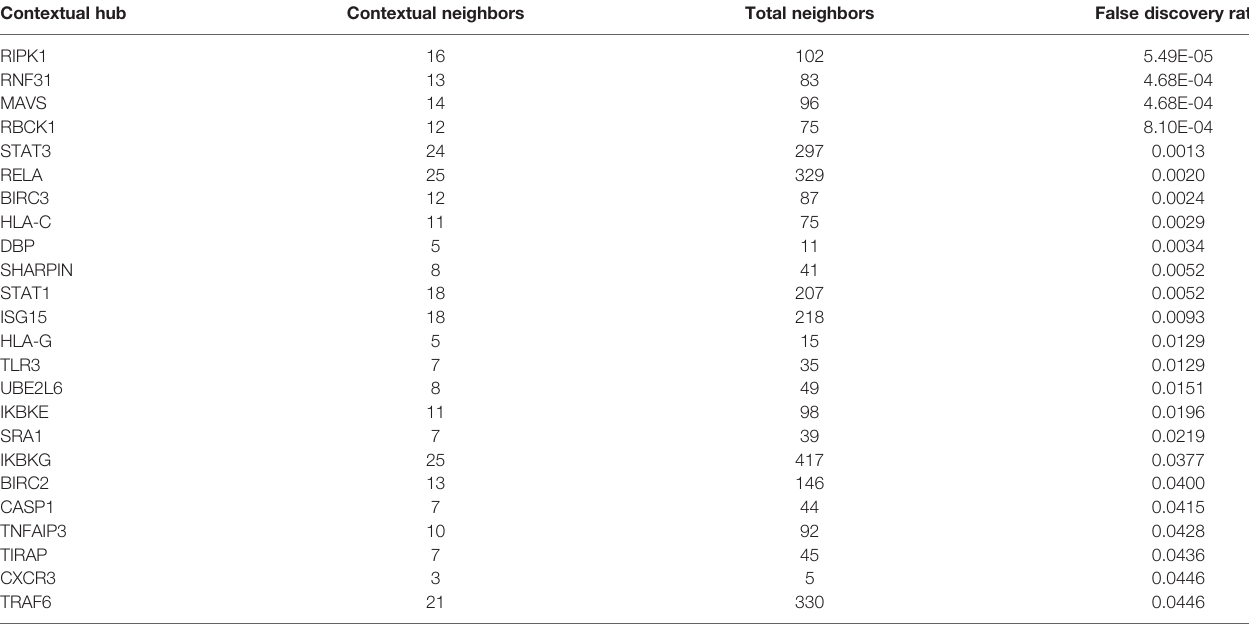
BIRC3, baculoviral IAP repeat-containing protein; CASP1, caspase 1, apoptosis-related cysteine protease; CXCR3, chemokine, CXC motif, receptor 3; DBP , d-box-binding PAR bZIP transcription factor;HLA ,majorhistocompatibilitycomplex,classI;IKBK,inhibitorofnuclearfactorkappa-Bkinase;ISG15,ubiquitin-likemodi fi erISG15(a.k.a.interferon-inducedprotein